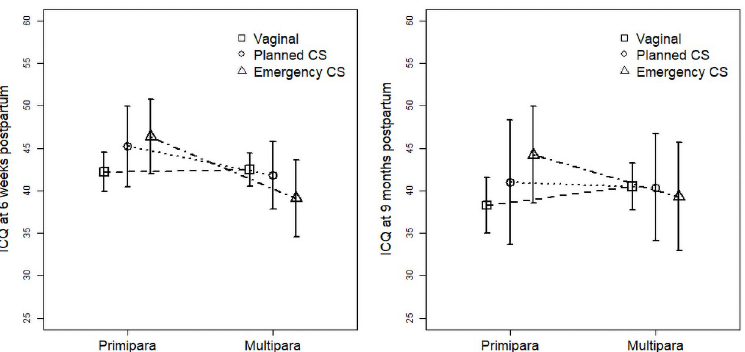
Fig 1. The effect of parity on the association between the mode of delivery and infant temperament at 6 weeks and 9 months